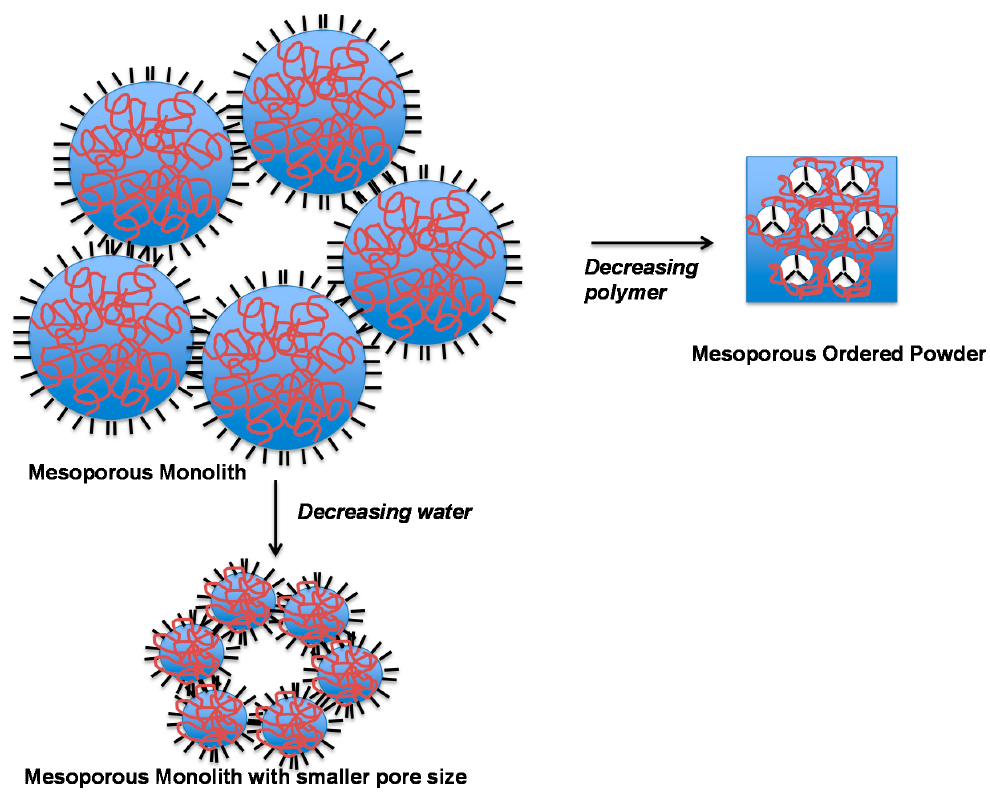
Figure 16. Schematic representation of the mesoporosity of the materials: mesoporous monoliths or ordered mesoporous powder as a function of polymer (DM-970) amount and water content. Blue is for silica, Black is the alkyl chain of the polymer, Red is the EO chain of the